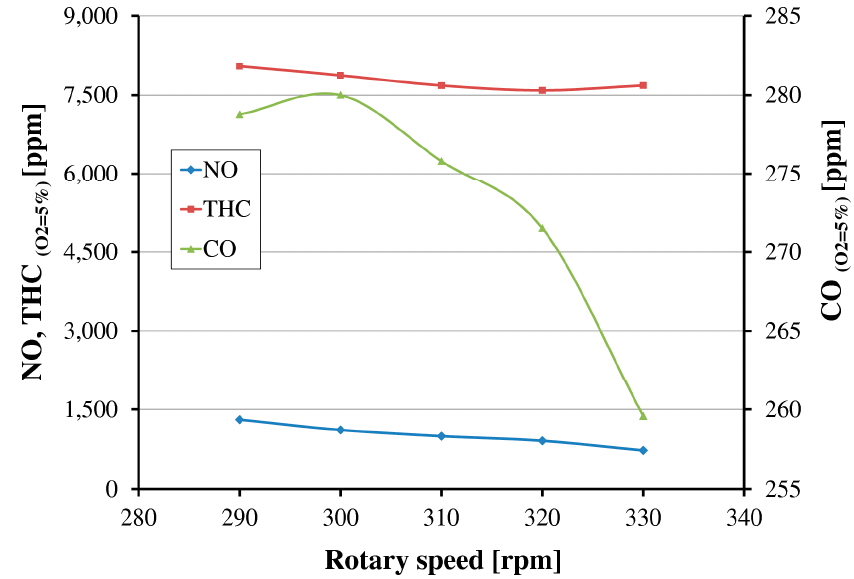
Figure 10. Overall emission for gas engine GMVH-12 with pre-combustion chamber ignition system.